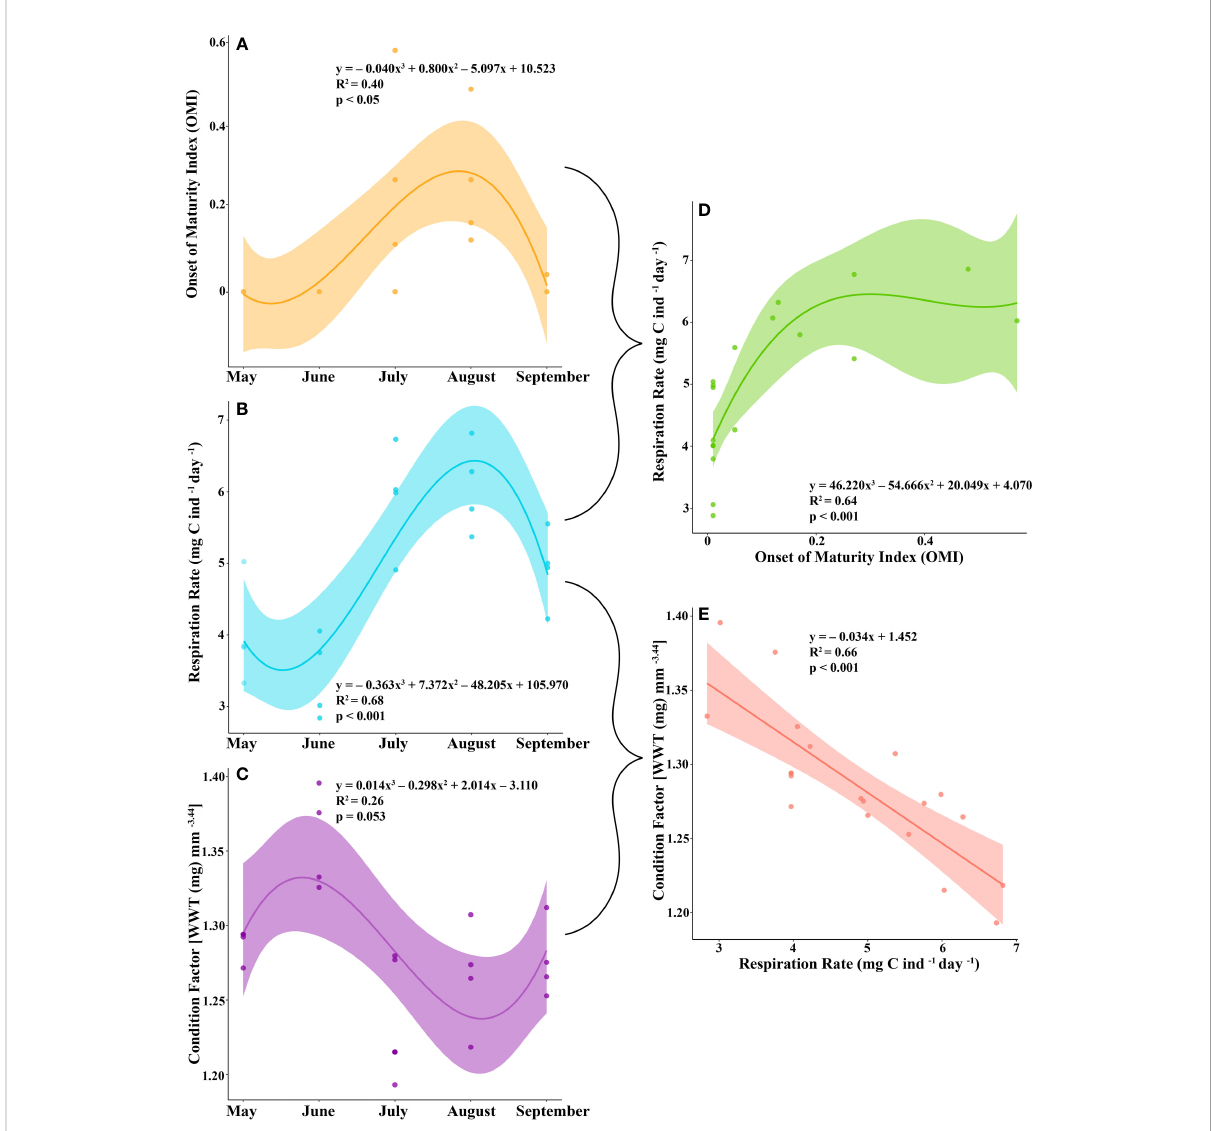
FIGURE 2 The (A) onset of maturity index (OMI), (B) respiration rate (mg C ind -1 day -1 ), and (C) condition factor [wet weight (WWT; mg) mm -3.44 of juvenile krill from May to September. The relationship between (D) OMI and respiration rate and (E) respiration rate and condition factor.